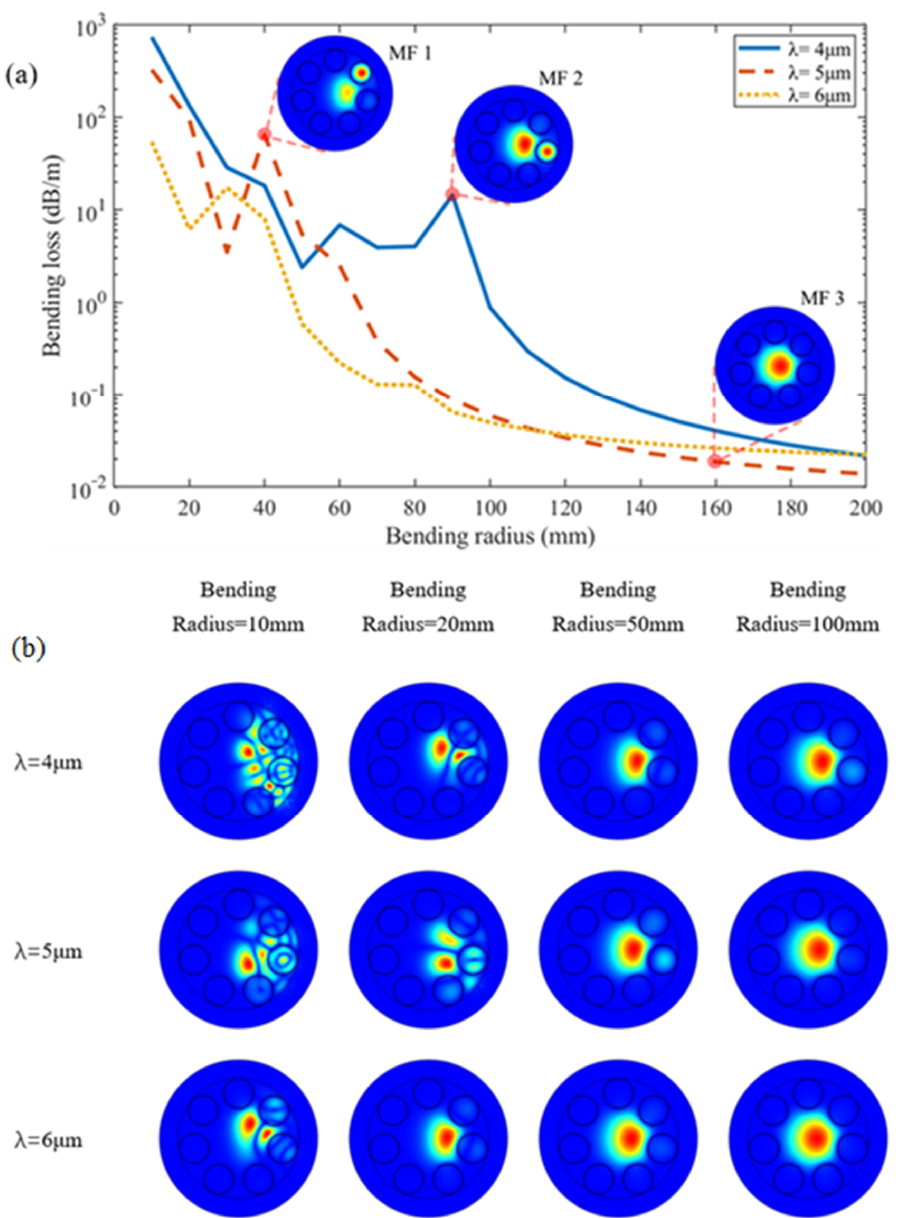
Figure 5. ( a ) Bending loss of the HCF with respect to bending radius when the transmission wave- length is 4 µ m, 5 µ m and 6 µ m. Optical mode distributions for some marked points are included; ( b ) the corresponding optical mode distributions at wavelengths of 4 µ m, 5 µ m and 6 µ m, when the bending radii are 10 mm, 20 mm, 50 mm and 100 mm